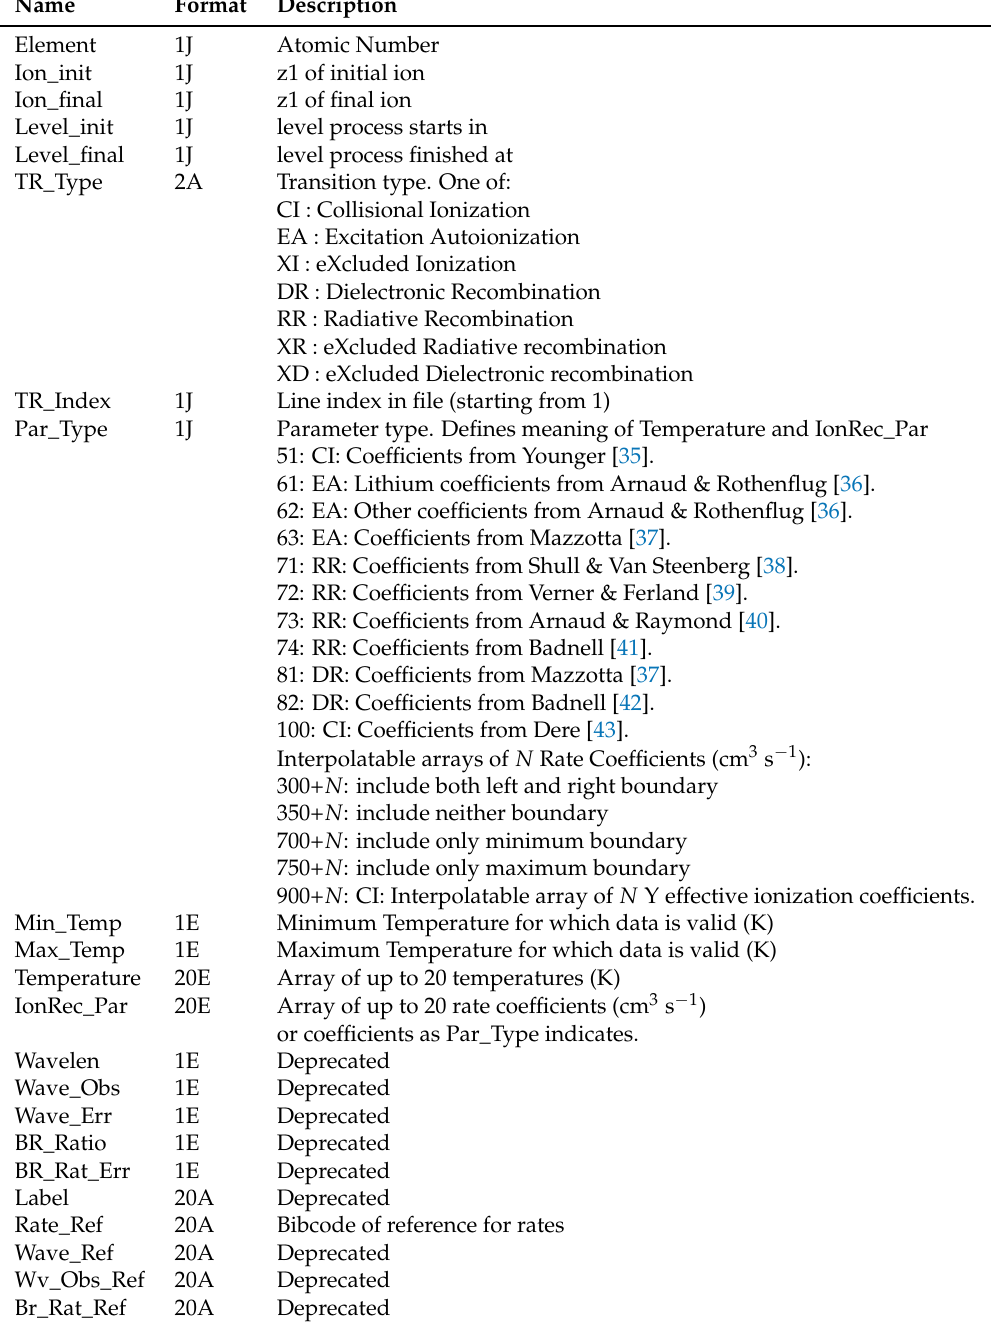
Table A1. APED IR (ionization and recombination rate) file definition. Excluded data types (XI, XR, and XD) are used to populate excited levels of ions but are not used when calculating the charge state distribution. The effect of these rates is included in the CI, EA, DR, and RR total rates used for calculating the charge state distribution. Notable header keywords: IONPOT contains the ionization potential in